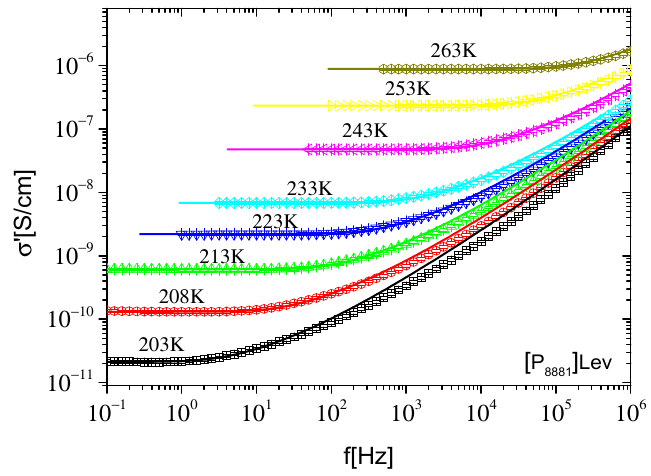
Figure 5. Real part of conductivity σ′ as a function of frequency f at different temperatures, indicated on the plot, for [P 8881 ]Lev. The lines are best fits of the expressions of the original RBM performed in the frequency region of the dc–ac transition and extrapolated to the whole frequency range.